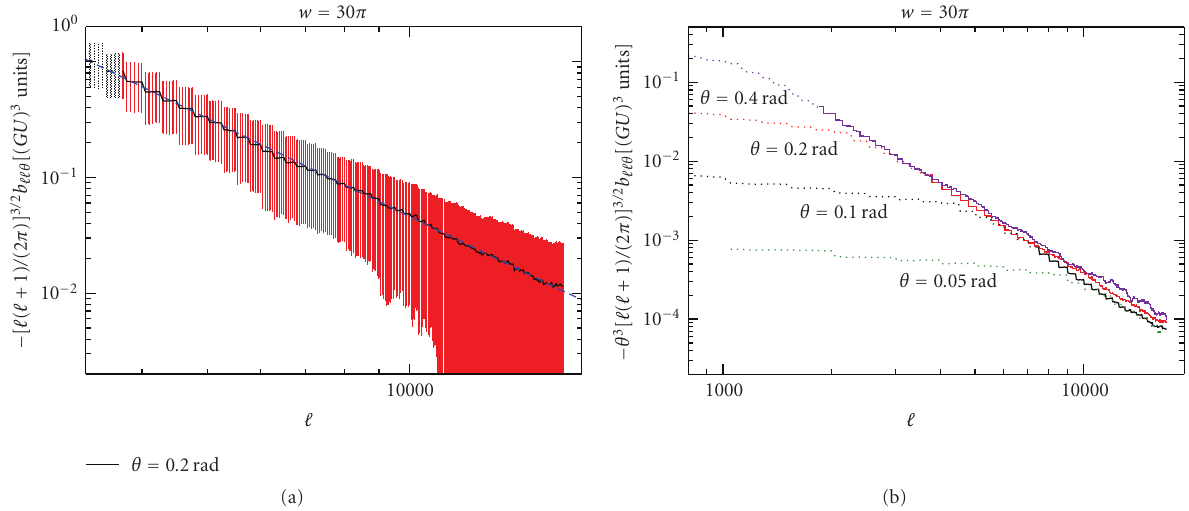
Figure 19: (a): mean value and standard deviation of the squeezed isosceles bispectrum [ (cid:15) ( (cid:15) + 1) / (2 π )] 3 / 2 b (cid:15)(cid:15)θ for θ = 0 . 2 radians. The dashed line is the best power law fit. (b) shows its rescaling by θ 3 [ (cid:15) ( (cid:15) + 1) / (2 π )] 3 / 2 b (cid:15)(cid:15)θ showing the 1 /θ 3 dependency. The spurious plateau (dotted) for the lower multipoles comes from a numerical cuto ff associated with the window functions and occurs at (cid:15) min ( θ ) (cid:2) 30 π/ ( θ fov θ ), the field of view being θ fov = 7 . 2 ◦ .